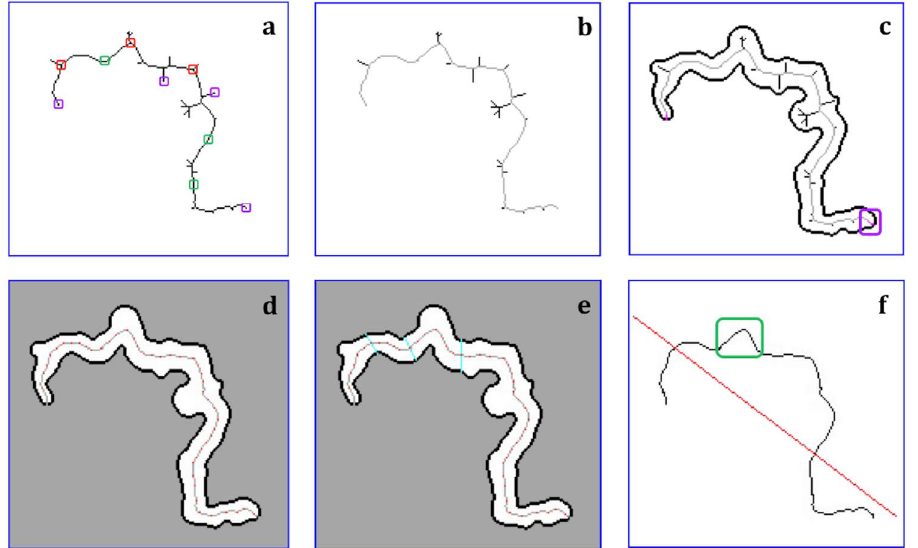
waves recognition (one wave is enclosed in green as example).